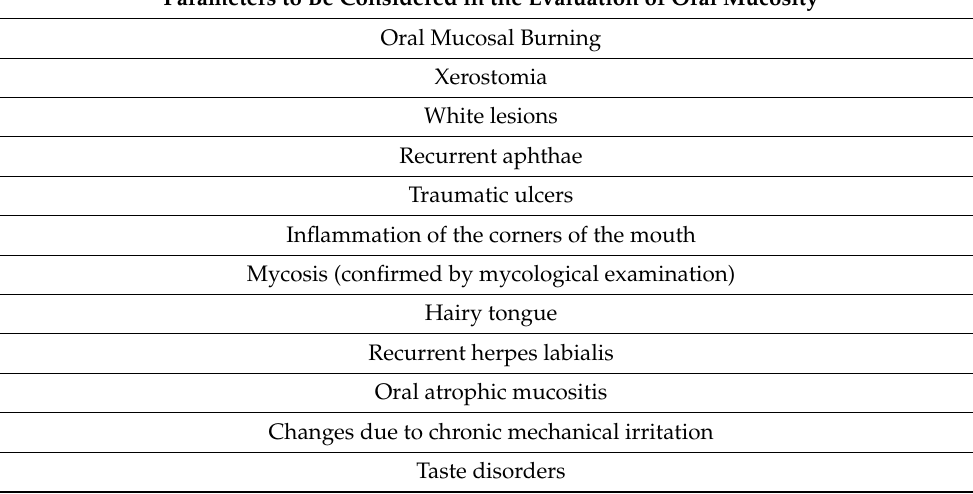
Table 2. Parameters considered in the assessment of oral